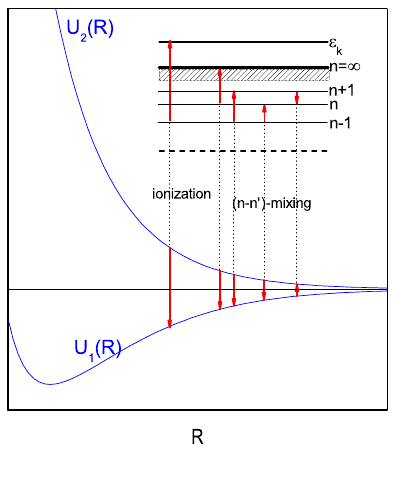
Figure 1. The graph of schematic illustration of the resonant transitions which cause the processes of chemi-ionization/recombination and ( n − n (cid:48) )-mixing processes in the A ∗ ( n ) + A